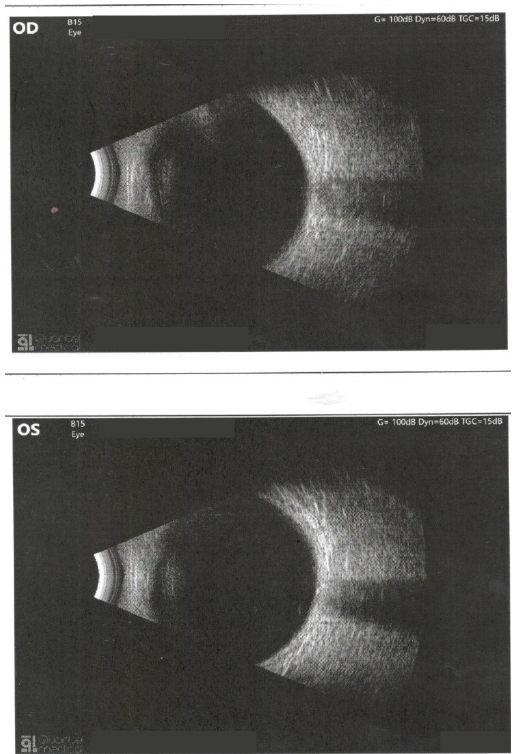
Figure 6. ONH and RNFL analyses.